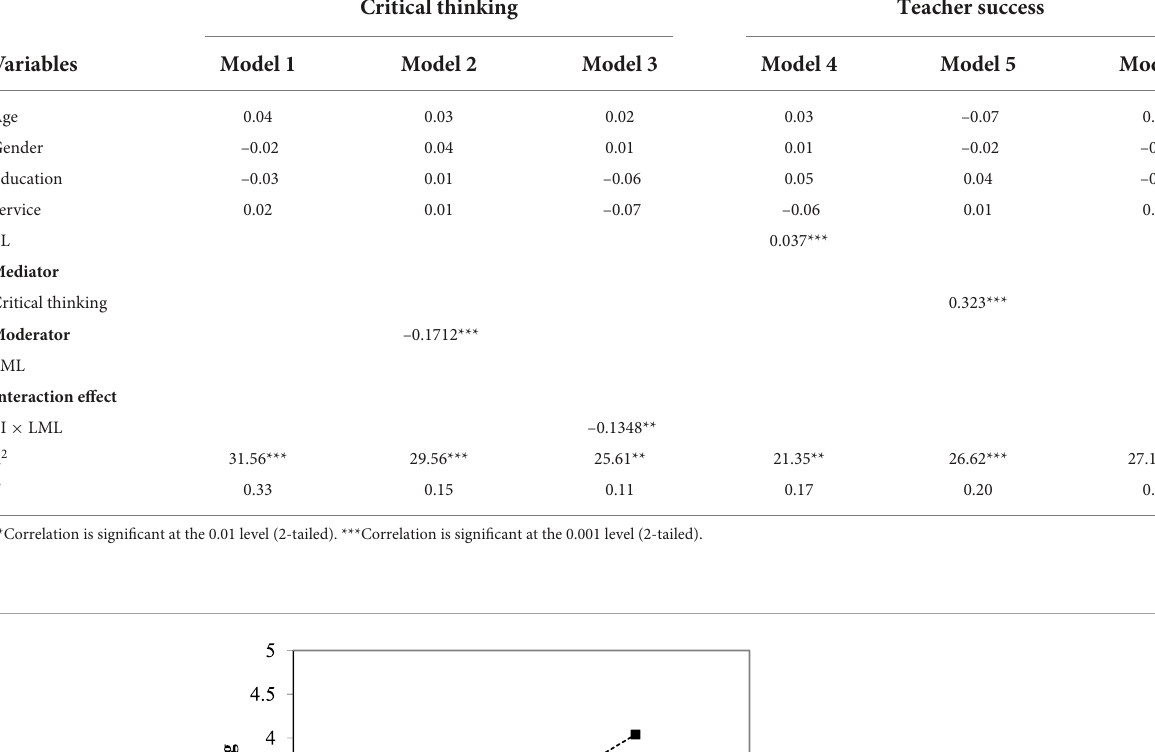
TABLE 3 Hierarchical linear regression results.